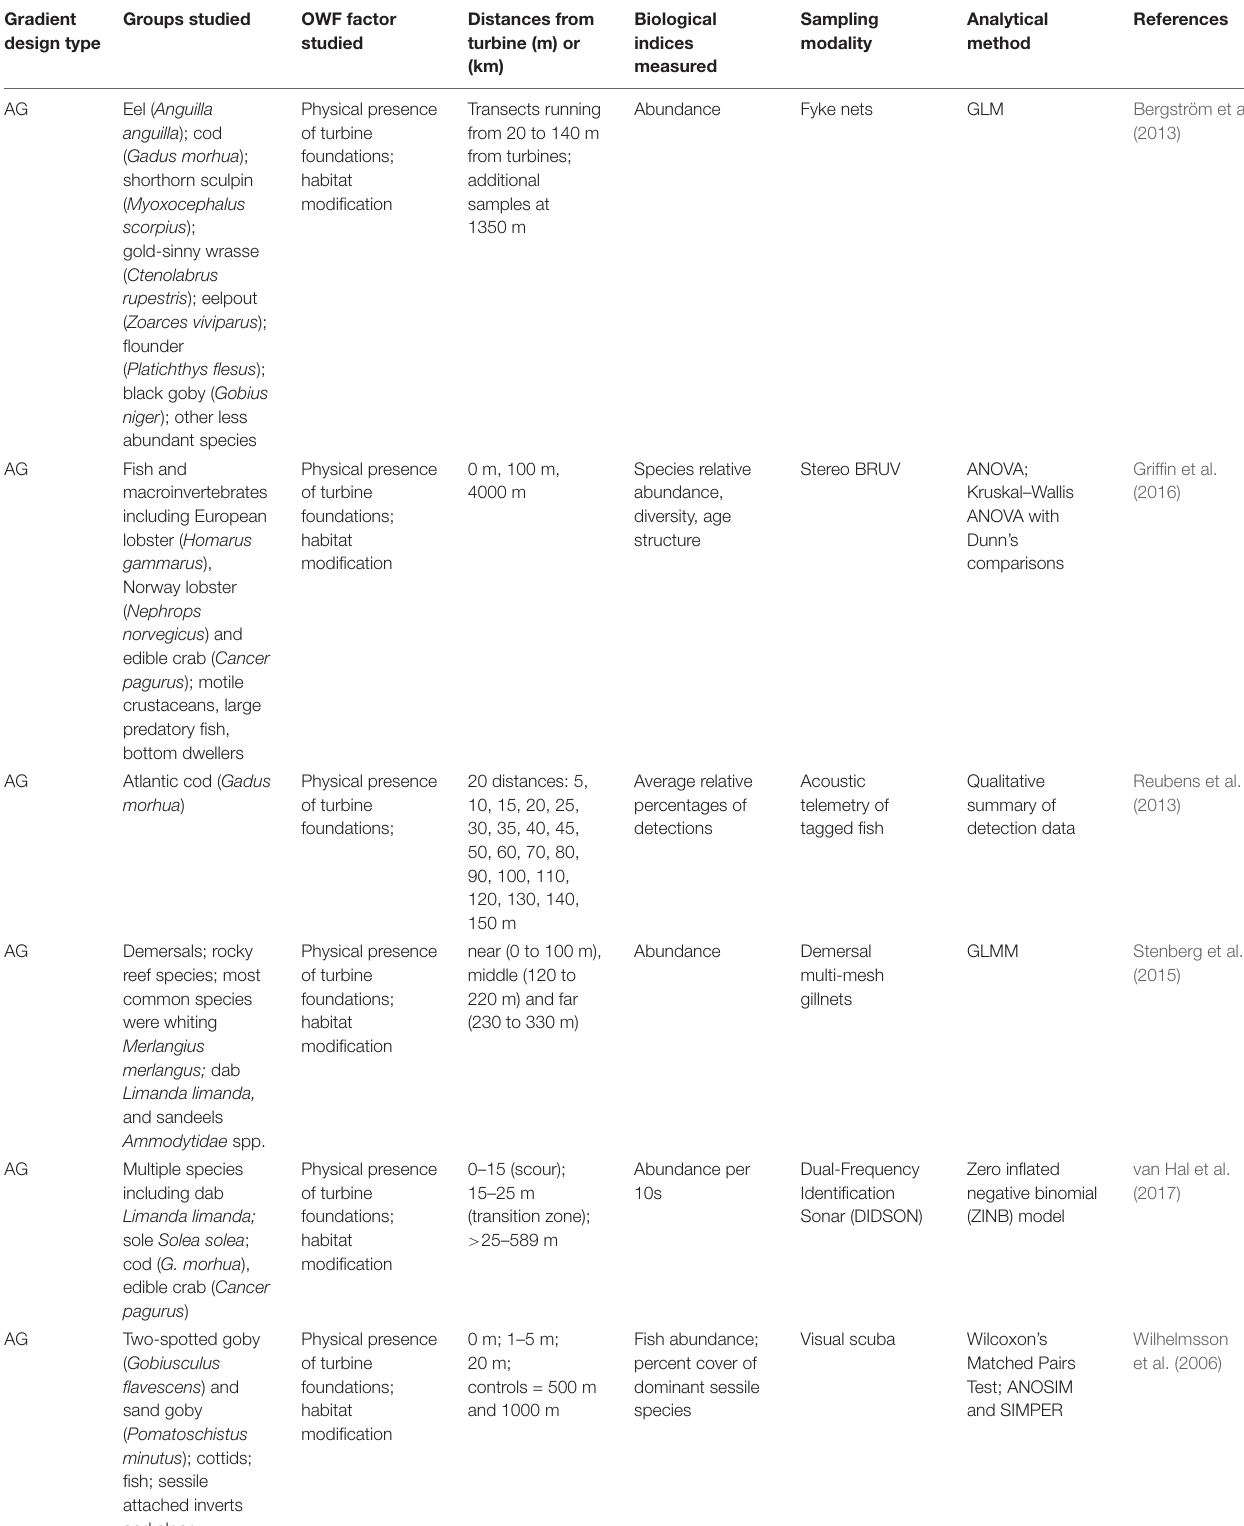
TABLE 3 | Studies of finfish that used a gradient design to examine the effects of OWF development. Gradient Groups design type